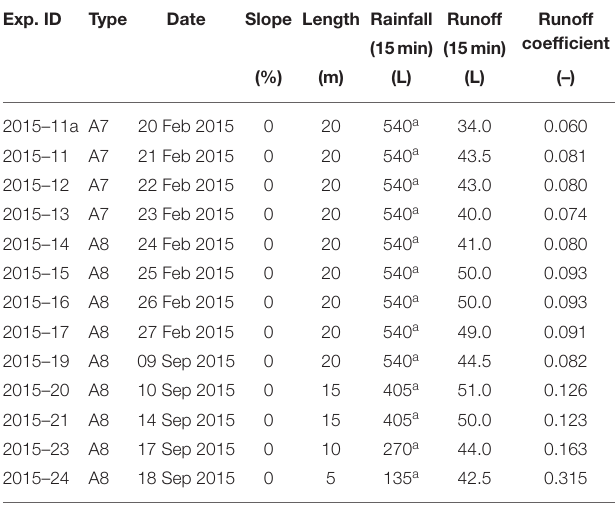
TABLE 2 | Artificial rainfall experiments carried out in 2015 with 0% slope.